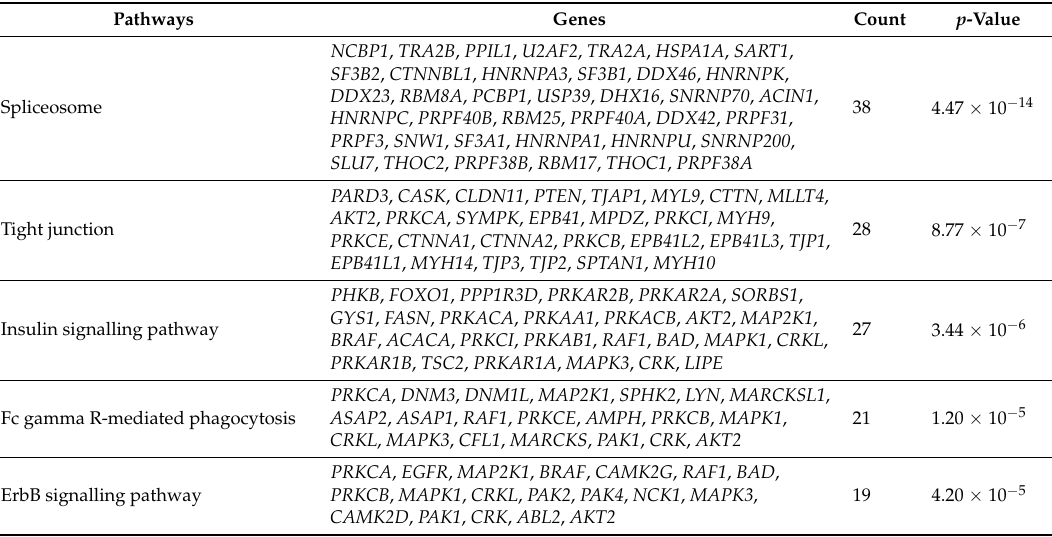
Table 1. Pathways found to be enriched in retina and retinoblastoma